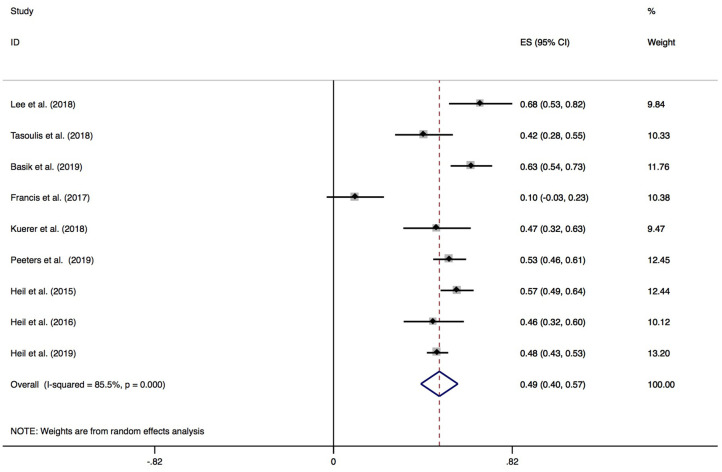
Forest plot of meta-analysis on breast pCR rate of surgical specimen.